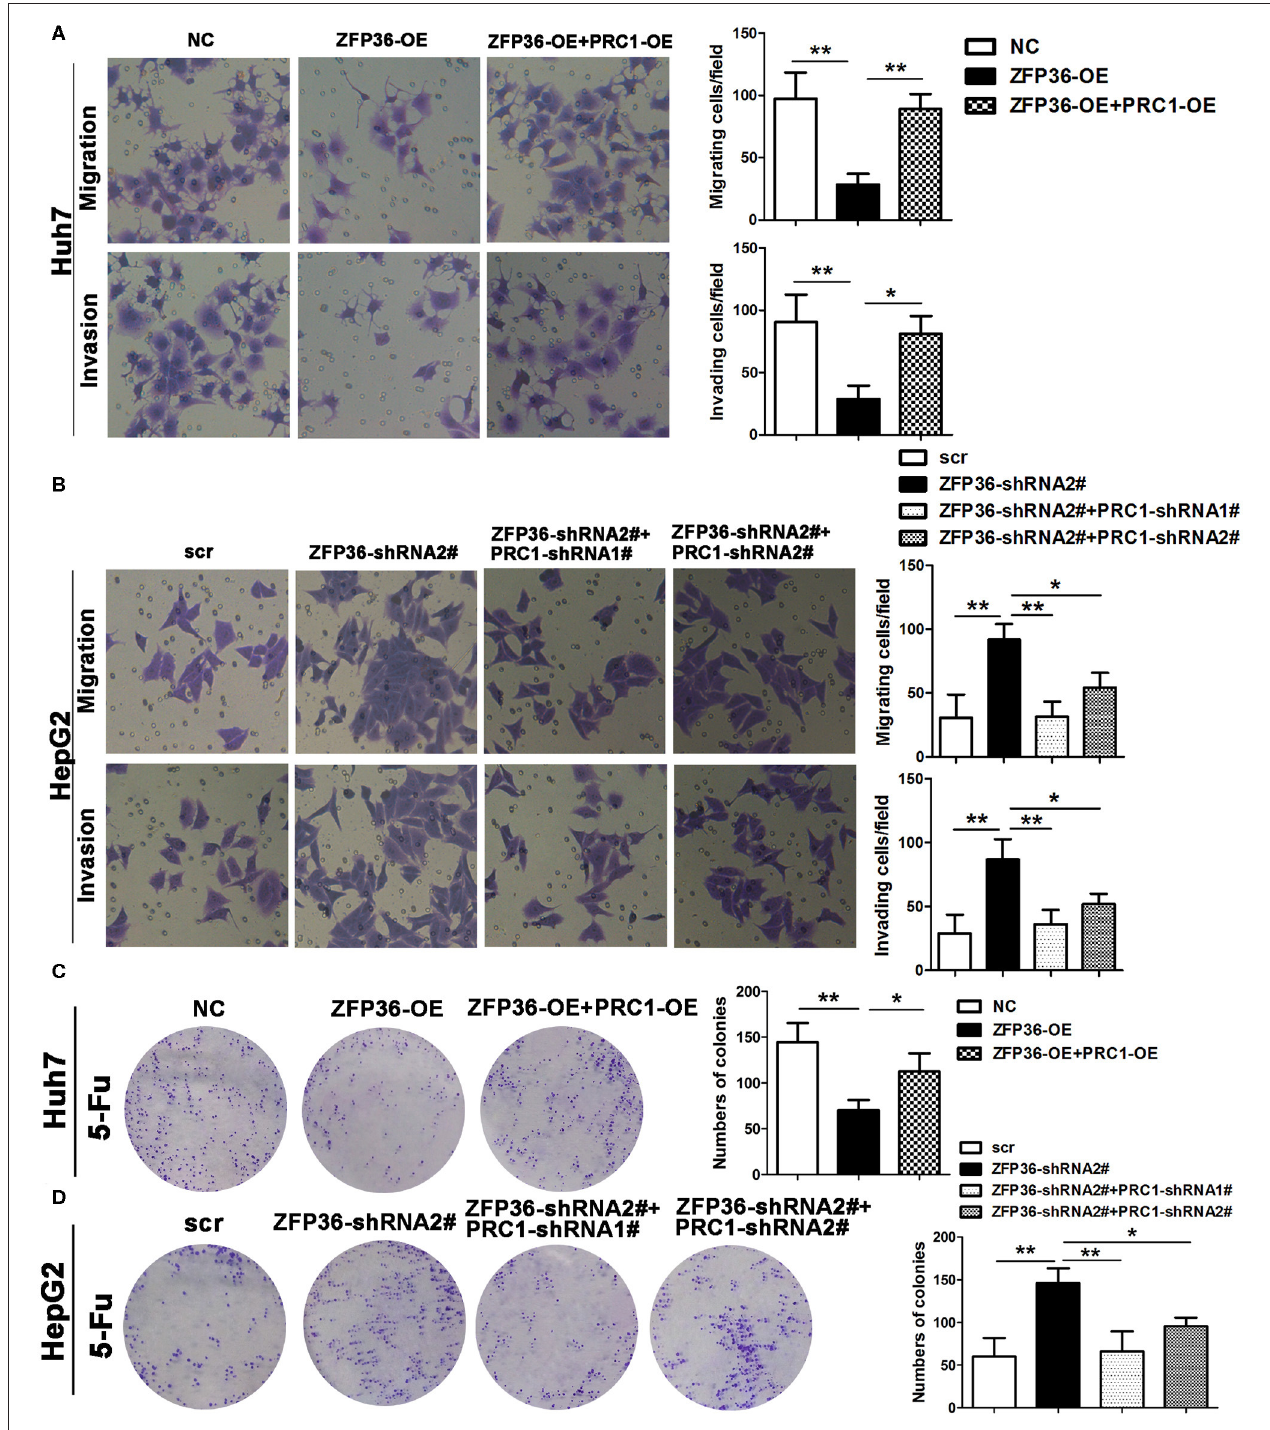
FIGURE 8 | Overexpression of ZFP36 decreases cell migration and invasion and increases sensitivity to 5-Fu treatment by the downregulation of PRC1 expression. (A,B) Huh7 cells were transfected with negative control (NC), ZFP36-OE alone, or co-transfected with ZFP36-OE and PRC1-OE; HepG2 cells were transfected with scr, ZFP36-shRNA2#, or co-transfected with PRC1-shRNA1# or 2# and ZFP36-shRNA2#. Migration and invasion were detected by Transwell assay. (C,D) Huh7 cells were transfected with NC, ZFP36-OE alone, or co-transfected with ZFP36-OE and PRC1-OE; HepG2 cells were transfected with scr, ZFP36-shRNA2#, or co-transfected with PRC1-shRNA1# or 2# with ZFP36-shRNA2#; Cells were grown for 14 days with 135 µ g/ml 5-Fu for Huh7 cells or 110 µ g/ml 5-Fu for HepG2 cells and stained with crystal violet. The colonies were counted and captured. * p < 0.05, ** p < 0.01.